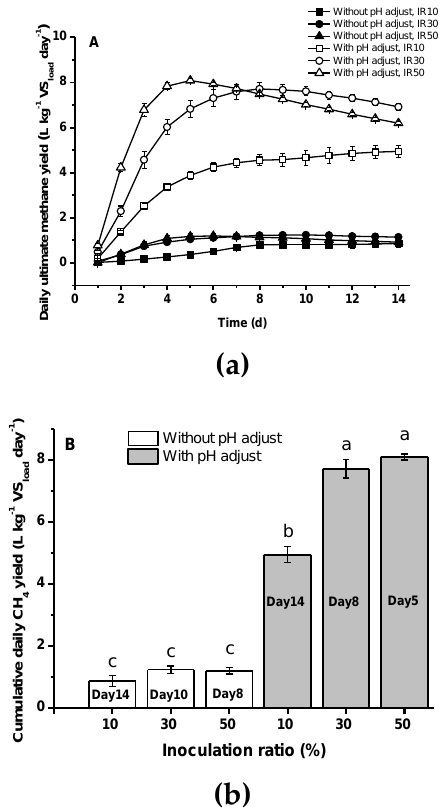
Figure 9. Effect of pH adjustment and different IR on the daily methane yield ( a ) and cumulative methane yield ( b ). Data of each column indicate mean and its standard deviation of triplicates. Days on each bar of the Figure 9b indicate the days to reach the maximum methane yield in the 14-day experiment. Bars without the same lowercase letter(s) differ significantly ( p < 0.05).